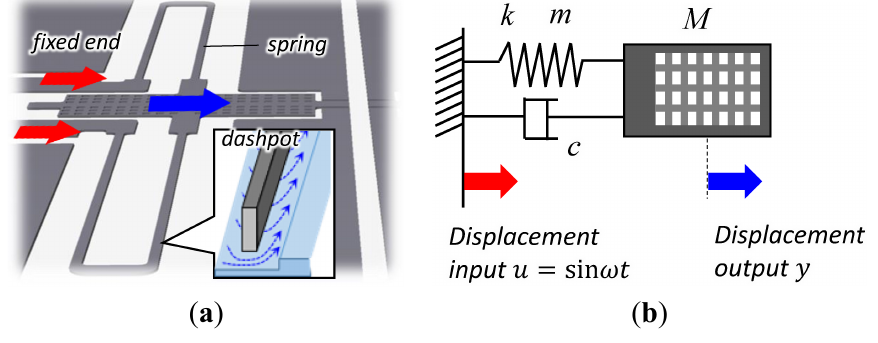
Figure 5. ( a ) Geometric illustration of the force sensor and ( b ) established 1-DOF mechanical